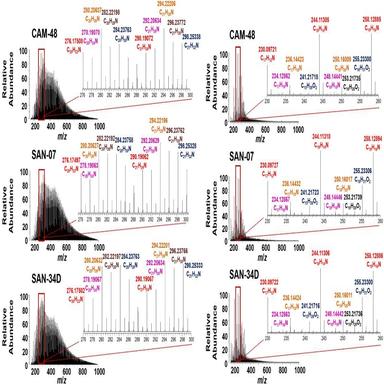
Mass spectra obtained using (a) ESI(+)-Orbitrap-HRMS and (b) ESI(-)-Orbitrap-HRMS with an emphasis on homologous series of nitrogenated and oxygenated substances and some proposed molecular formulas.